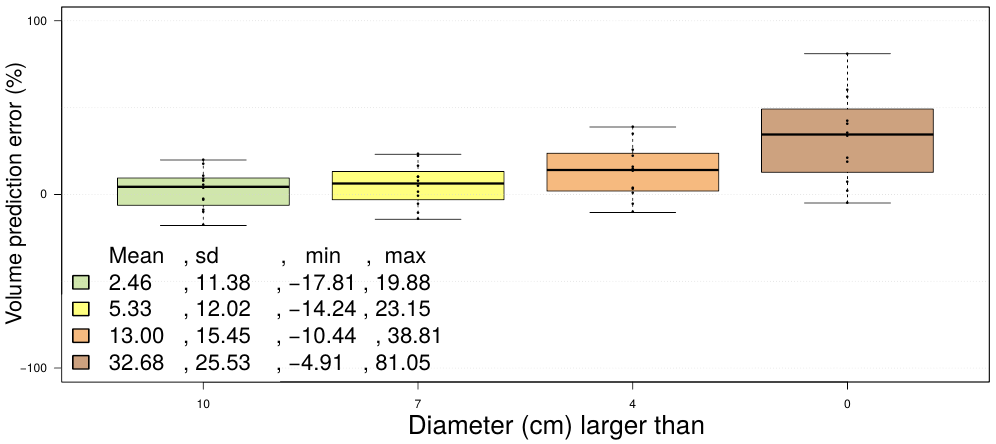
Figure 5. Box plots of the relative volume prediction error for Q. petraea . From left to right increasingly thinner branches are included in the analysis.